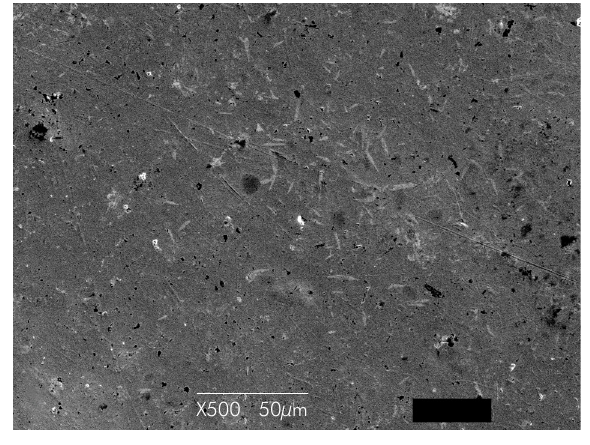
Figure 4. Photomicrograph from Group RL at 500x magnification.